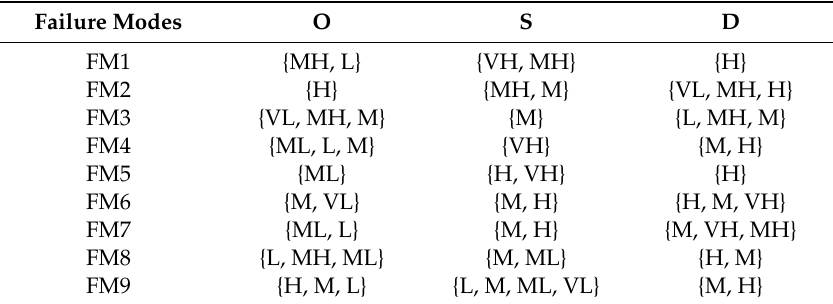
Table 7. Hesitant fuzzy decision matrix (linguistic variables form).